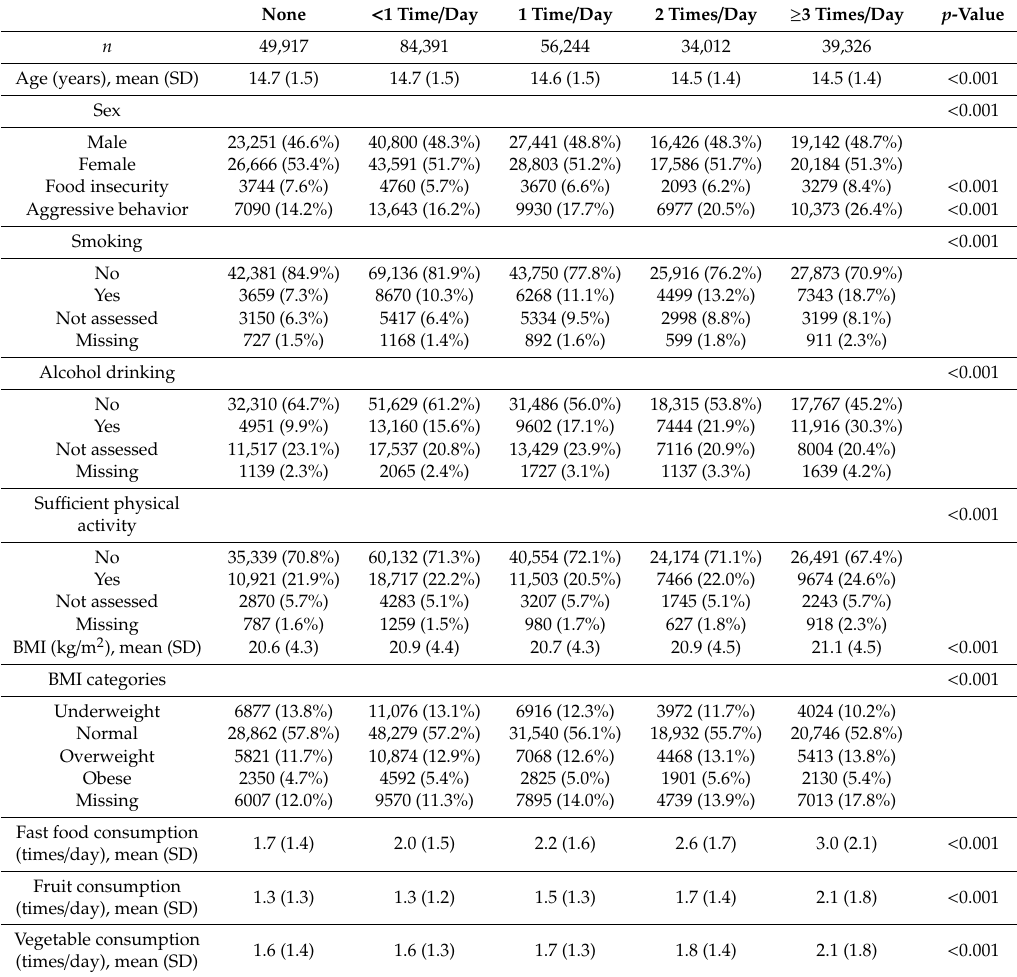
Table 1. Sample characteristics by levels soft drink consumption ( n = 263,890): the global school-based student health survey (GSHS) 1